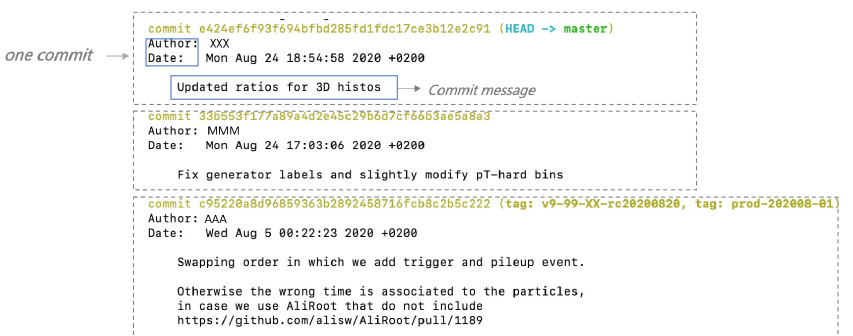
Figure 2. Original commit data.